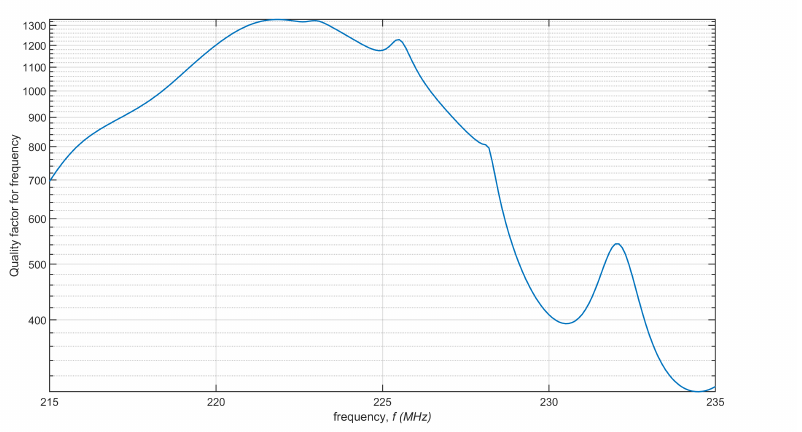
Figure 17. Quality factor for frequency as a function of frequency.